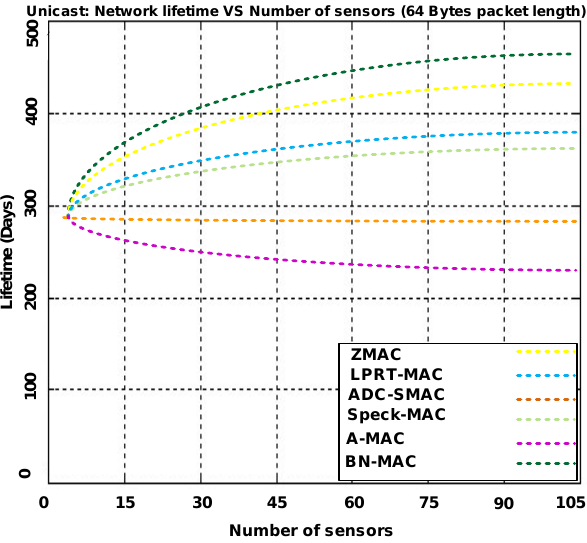
Figure 16. Lifetime of MAC protocols using a different number of sensors.